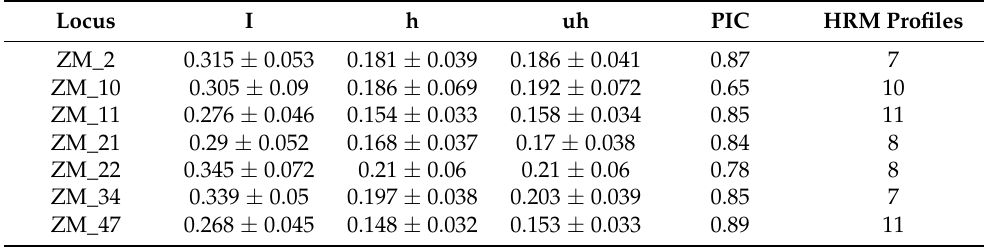
Table 3. Diversity statistics for seven expressed sequence tag-simple sequence repeat (EST-SSR) loci studied in 35 sesame landraces. Data are presented as mean values ± standard errors for each locus. Locus I h uh PIC HRM Profiles